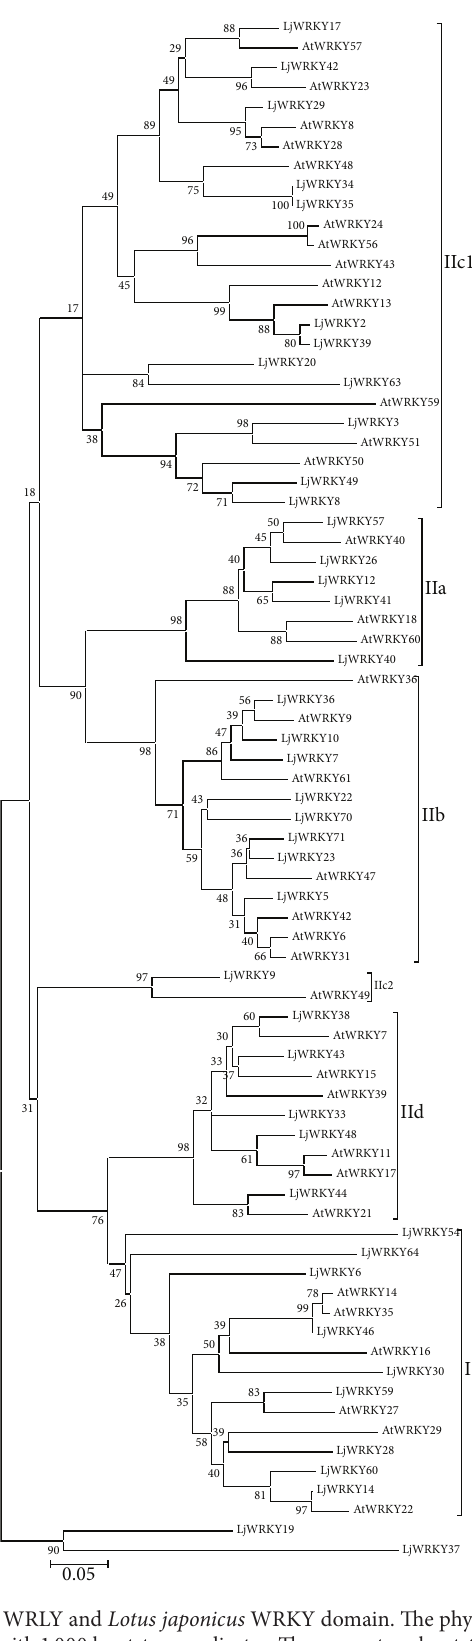
Figure 1: Phylogenetic tree of Arabidopsis WRLY and Lotus japonicus WRKY domain. The phylogenetic tree was constructed using MEGA 4.0 by the Neighbor-Joining (NJ) method with 1,000 bootstrap replicates. The percentage bootstrap scores higher than 50% are indicated on the nodes. The AtWRKY domains from Eulgem et al.